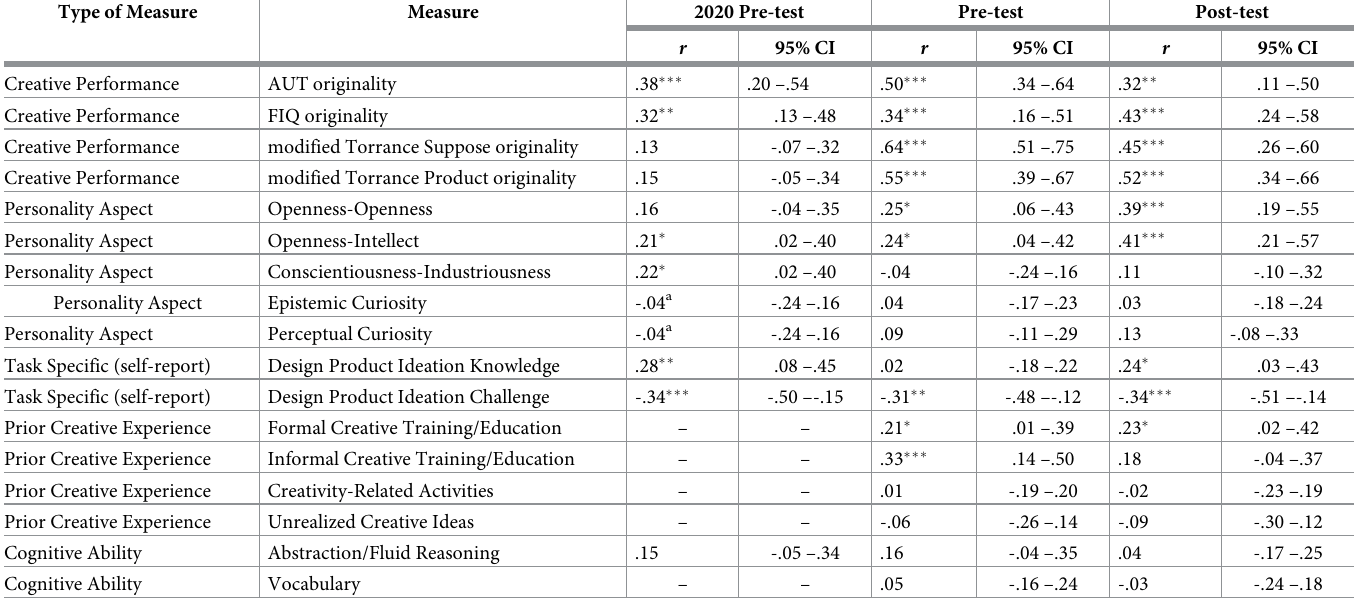
Table 6. Correlations with Design Product Ideation